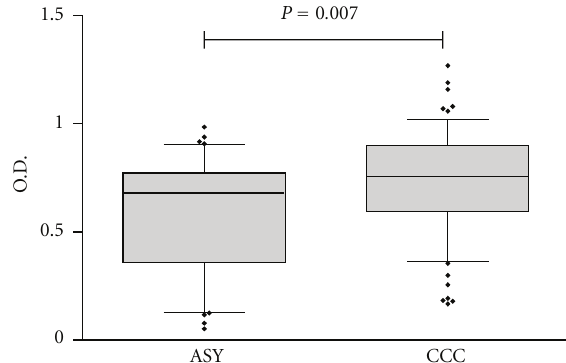
Figure 2: Direct ELISA for total IgG reactivity to recombinant B13 protein in the solid phase. Comparison between CCC (subjects with chronic Chagas Cardiomyopathy) and ASY (subjects with indeterminate/asymptomatic form of the disease). ASY and CCC subjects (median Abs. = 0.756 versus 0.681, resp.). The box plots whiskers show median values and 25–75% percentile; the 10% and 90% percentile; ou tlier points are shown above and below the